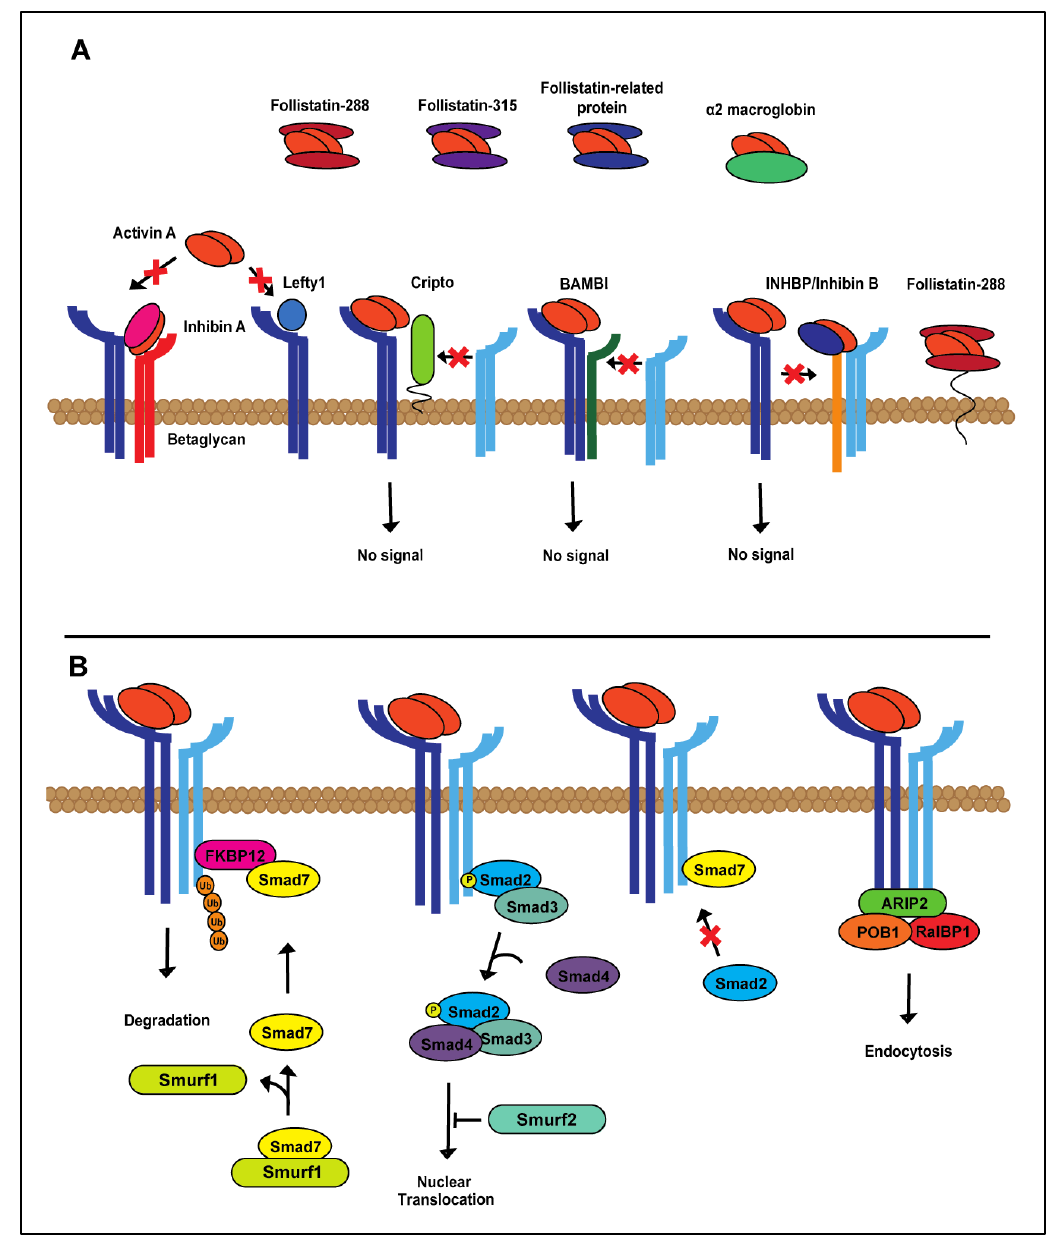
Figure 2. Extra- and intra-cellular regulation of activin A signaling. ( A ) Activin A is tightly regulated at the extracellular level by both extracellular matrix (follistatin-288, follistatin-315, follistatin-related protein, α2-macroglobin, left-right determination factor 1 (Lefty1), inhibin A) and membrane-bound proteins (betaglycan, Cripto, BAMBI, INHBP/inhibin B, follistatin-288). ( B ) In the cytoplasm, canonical activin A signaling is controlled during each step of the Smad